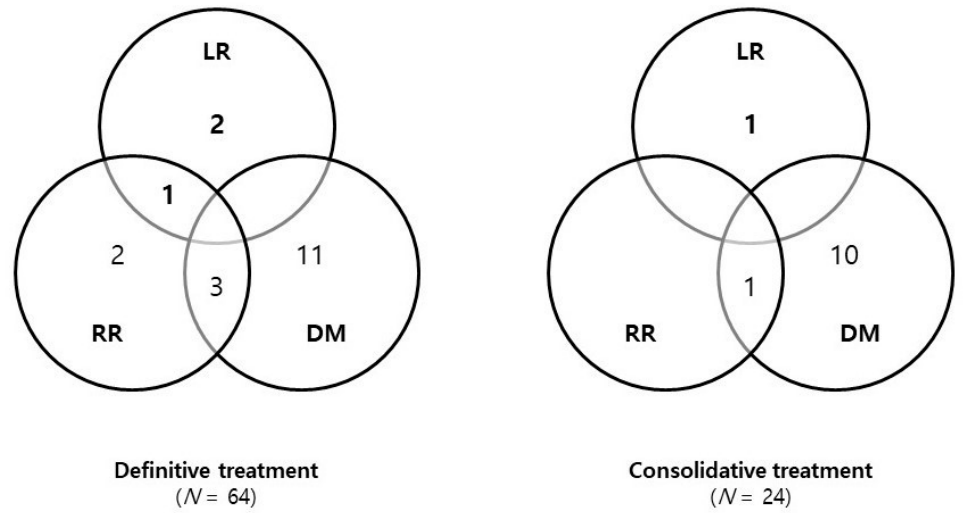
Figure 1. Patterns of failure in patients with non-small cell lung cancer according to treatment